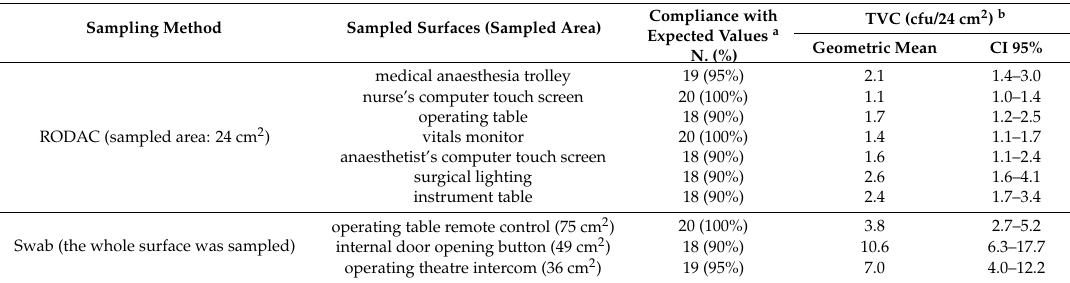
Table 3. Geometric mean, confidence intervals (CI 95%) of Total Viable Counts (TVC) in the surfaces monitored “at rest”. Comparison of the different sampled